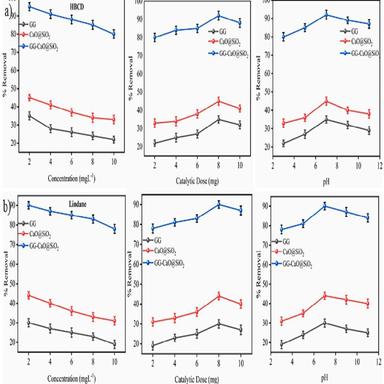
Concentration, dose, pH-based study of HBCD and Lindane by using synthesized GG- CaO@SiO2 nanocomposite and their native nanoparticles.